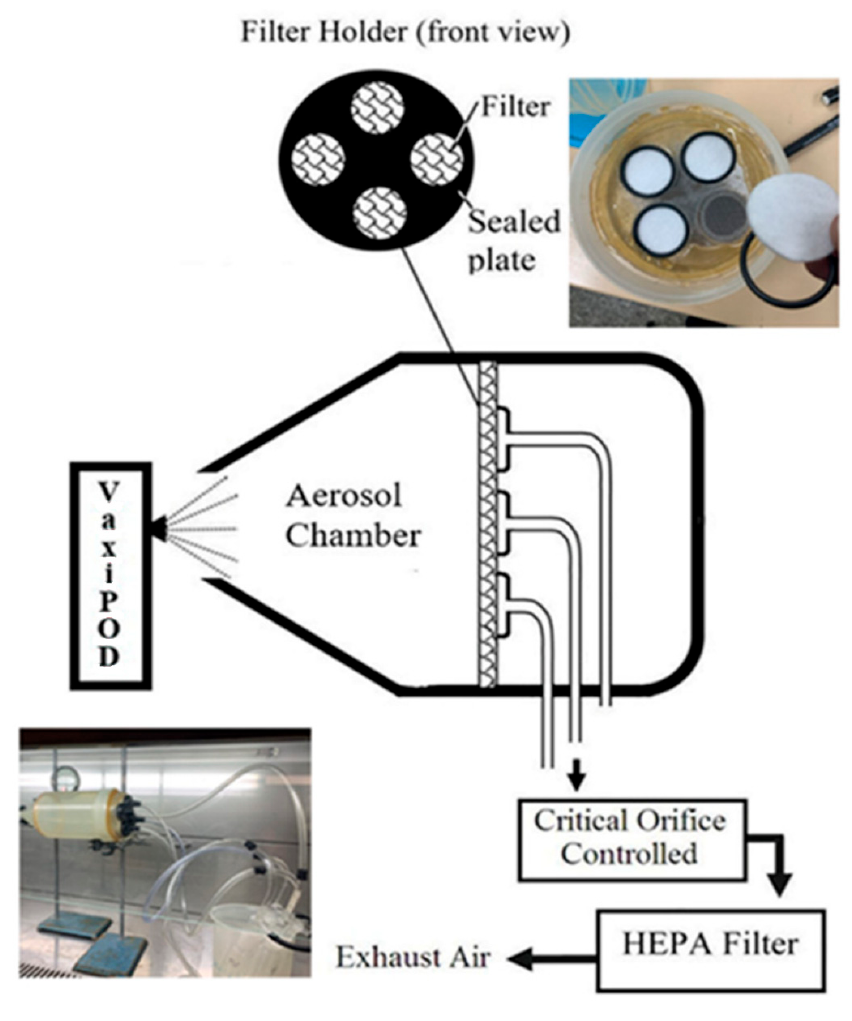
Figure 1. Microbial inactivation on filter surface–laboratory setup.